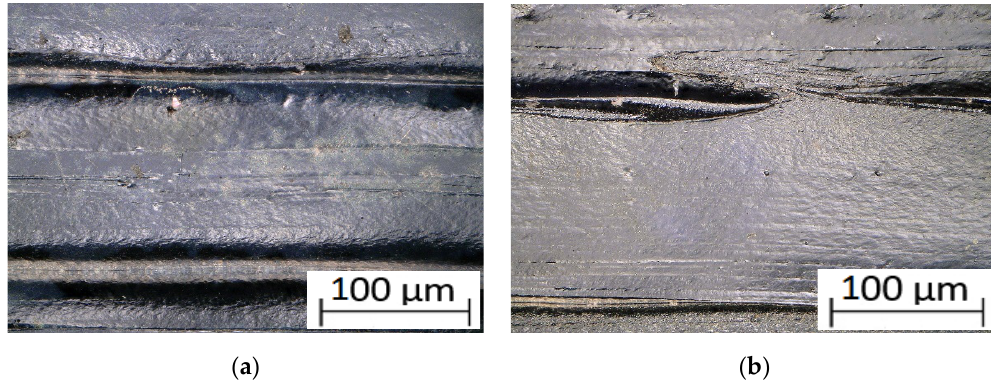
Figure 3. Digital microscopy images of the surface of acrylic-styrene-acrylonitrile (ASA)-coated ABS specimen ( a ) before and ( b ) after 1200 h of exposure to UV radiation and moisture.